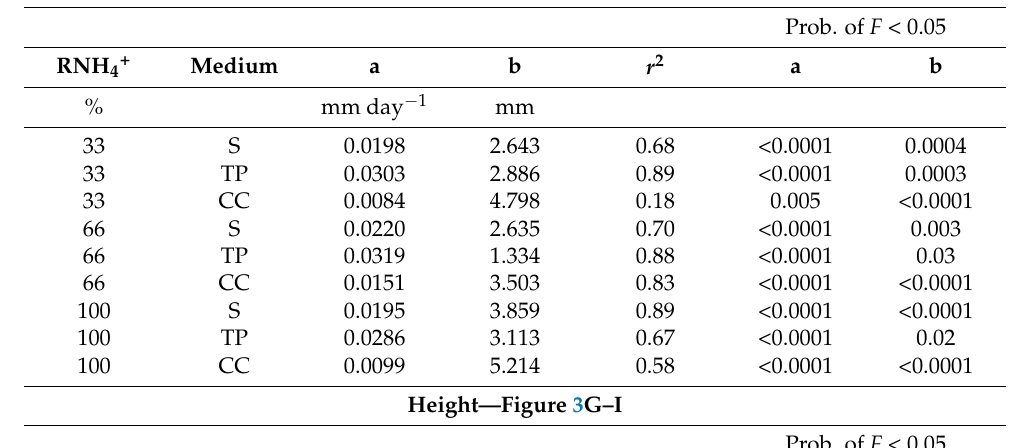
Cane Diameter—Figure 3D–F